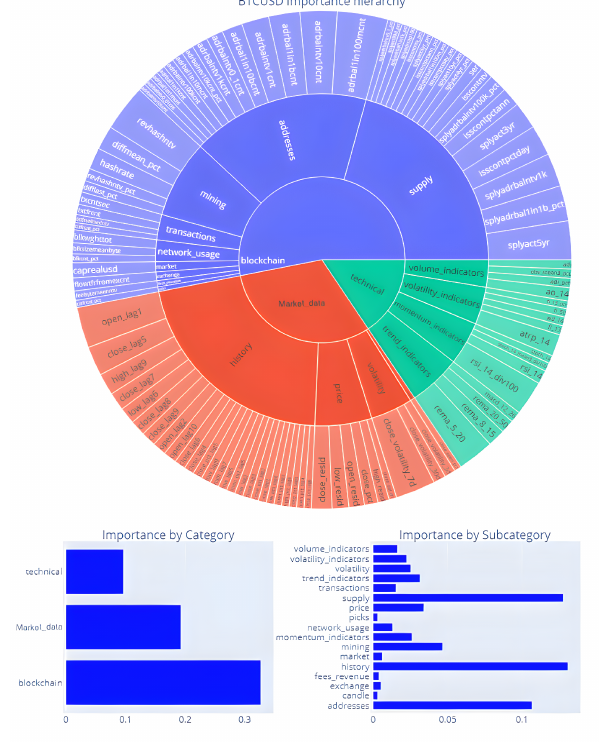
Figure 3. Hierarchical mean feature importance for BTCUSD.